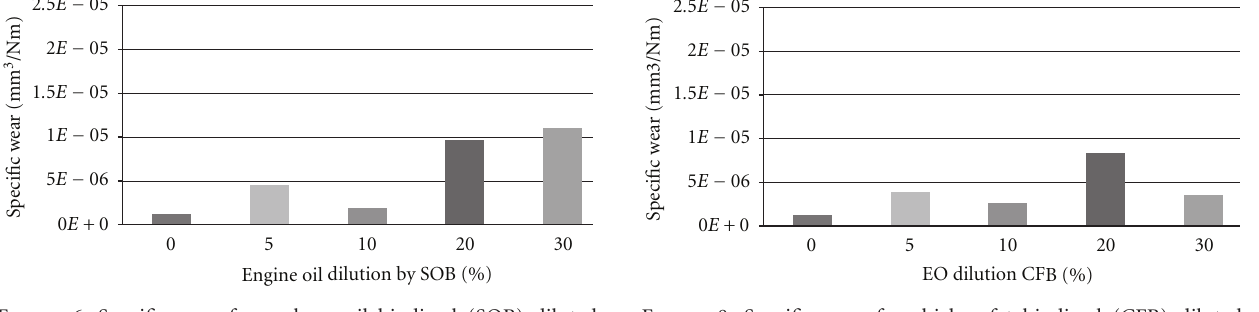
Figure 6: Specific wear for soybean-oil biodiesel (SOB) diluted engine oil mixtures.